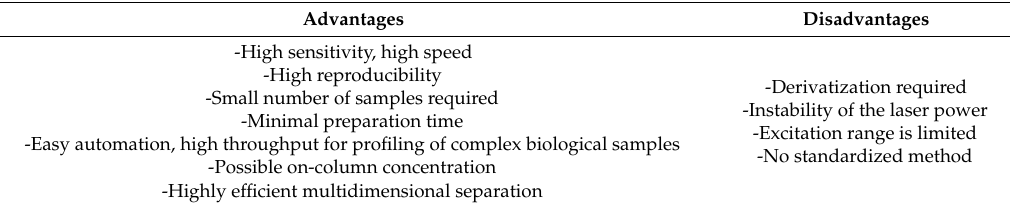
Table 3. CE-LIF based assay advantages and